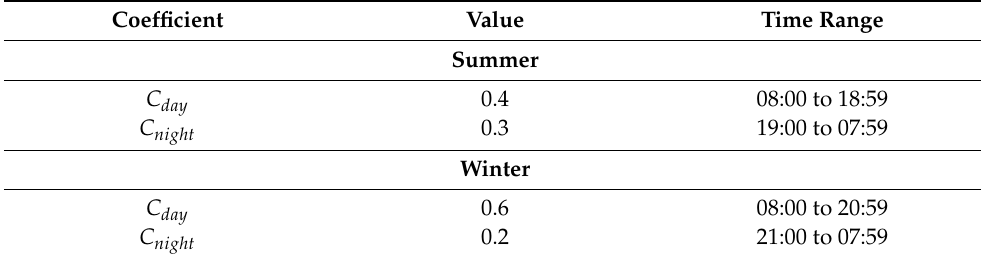
Table 4. Critical coefficient values for summer and winter.